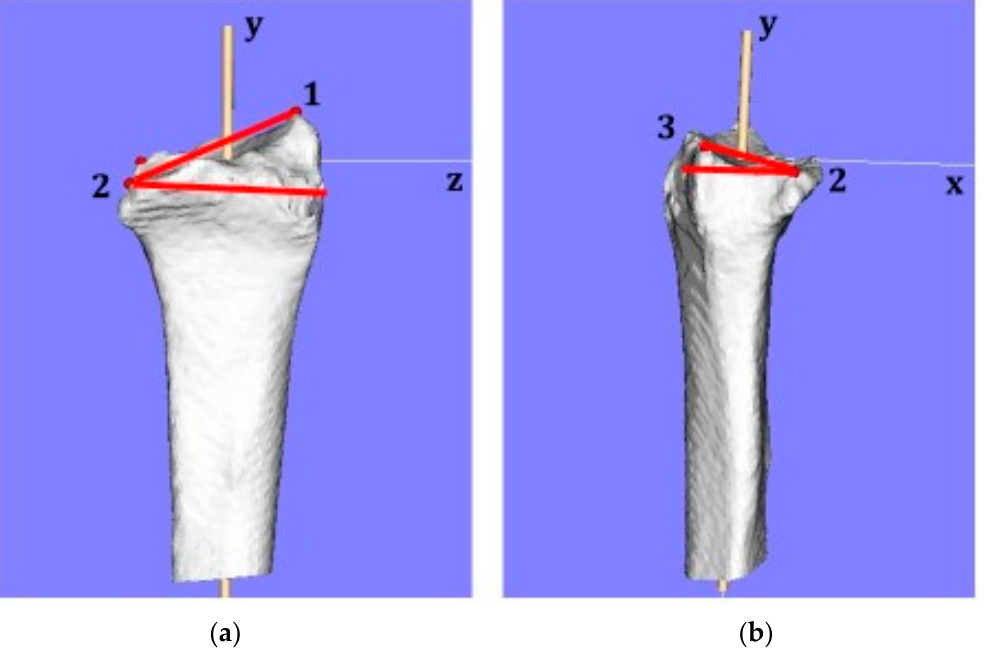
Figure 2. Articular surface and the position of barycentric coordinates. ( a ) The articular surface of the 3D model was identified with the bony prominence of the distal radius, ( b ) the articular surface was extracted, and ( c ) the surface area and position of the barycentric coordinates (red dots) were calculated. The bar indicates the long axis of the radius.